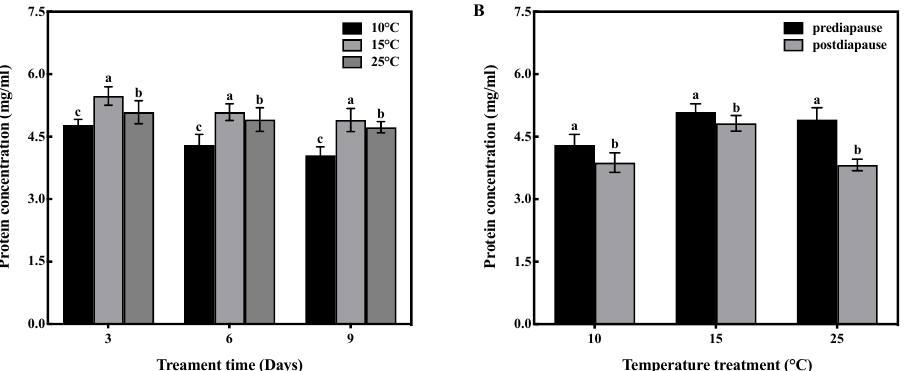
Figure 2. Effect of temperature acclimation on protein concentration in the fat bodies of queens. The values represent the concentrations (in mg/mL) of tissue samples of medium volume for each sample. ( A ) Effect of temperature acclimation on protein concentration in the fat bodies of queens during prediapause. Different letters represent statistical significance between the different temperatures ( p < 0.05). ( B ) Effect of temperature acclimation for 6 days during prediapause on protein consumption of queens during diapause. Different letters represent statistical significance between the different periods of diapause ( p < 0.05).